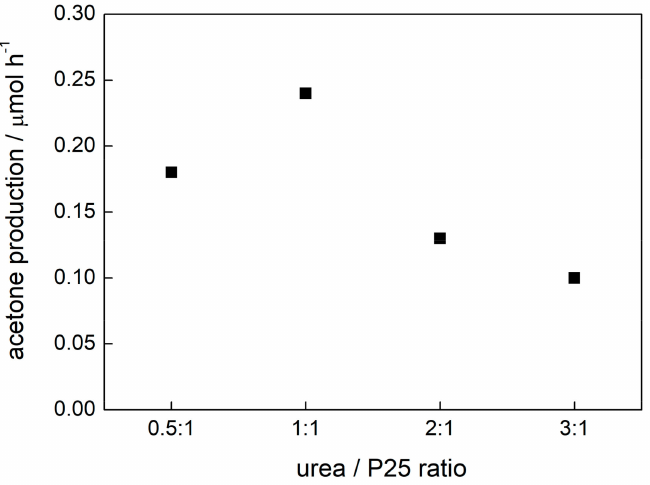
Figure 1. Visible light photocatalytic activity of the samples prepared with corresponding urea/P25